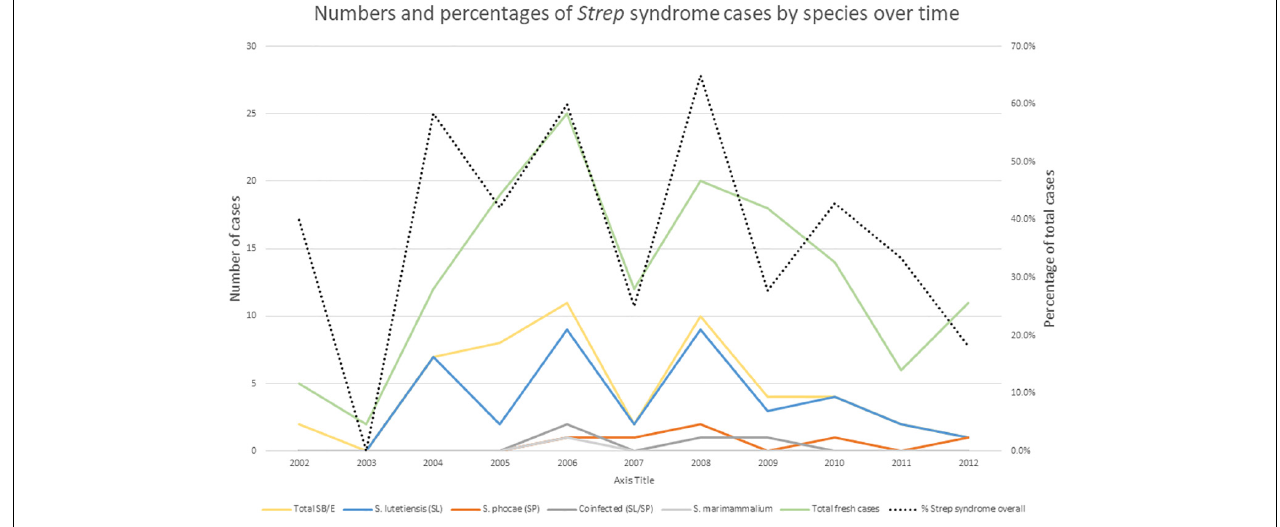
FIGURE 4 | Streptococci responsible for the Strep syndrome cases by year in fresh northern sea otters. Total Streptococcus bovis/equinus include S. lutetiensis (SL), S. gallolyticus ssp gallolyticus , S. gallolyticus ssp pasteurianus , and Streptococcus bovis/equinus non-specified. Doted black line indicates percent of Strep syndrome cases over total analyzed